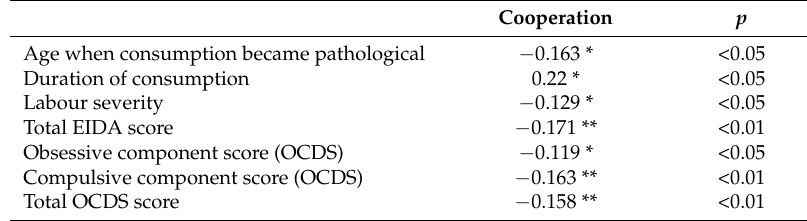
Table 6. Statistically significant correlations between Cooperation (TCI-R) and severity factors of the EIDA, OCDS and EuropAsi scales . (* p < 0.05; ** p < 0.001).